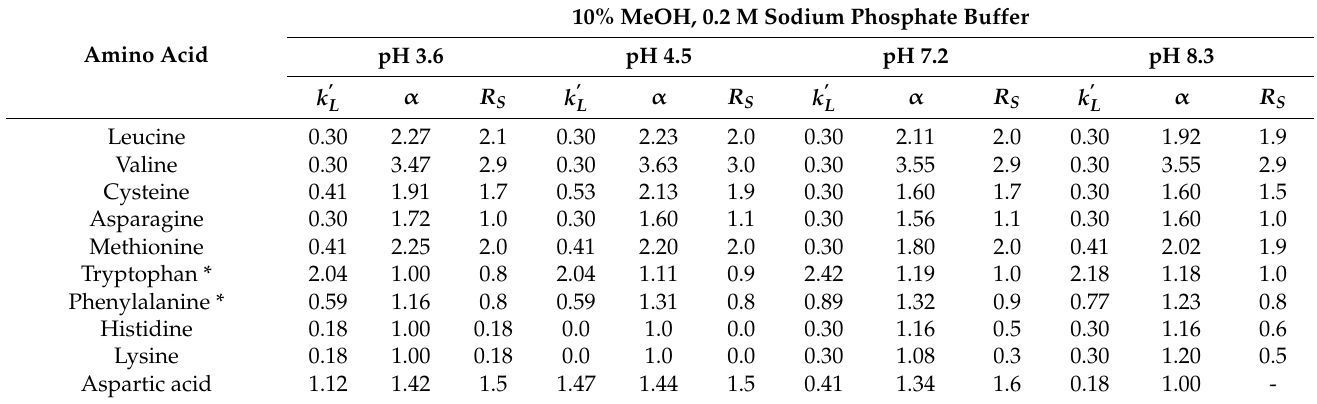
Table 4. Effects of pH on enantioselectivity, retention, and resolution for